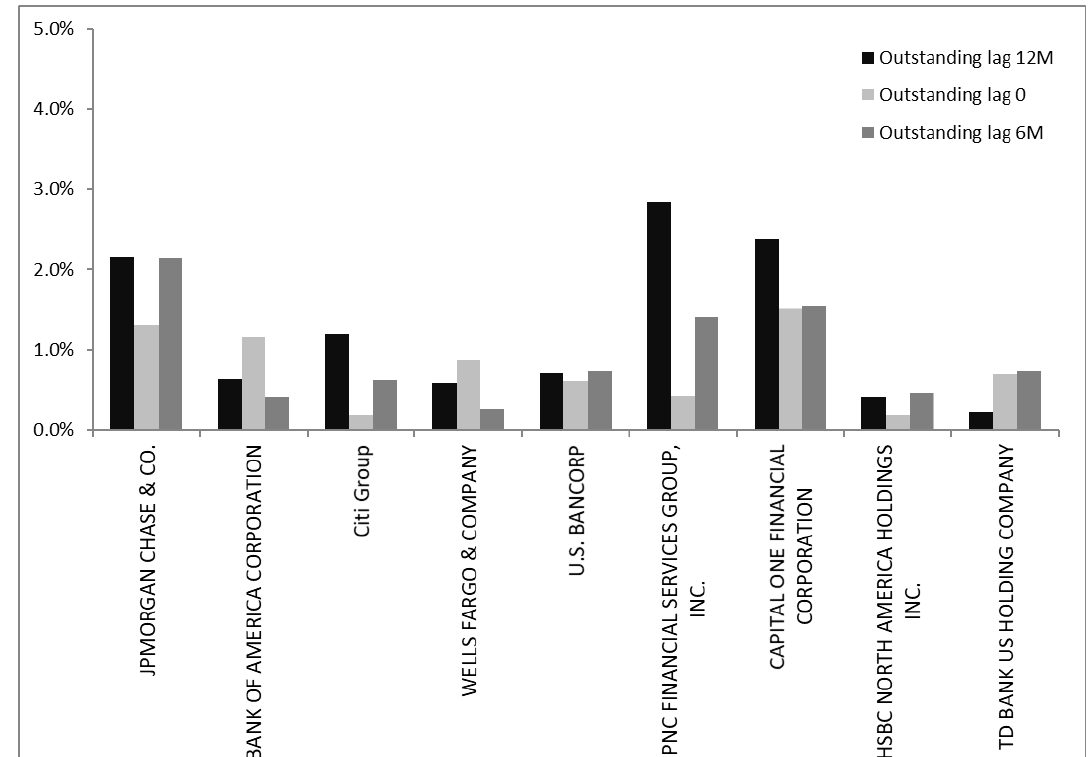
Figure 5. Correlations calculated for various lags of outstanding. Source: Author’s work.